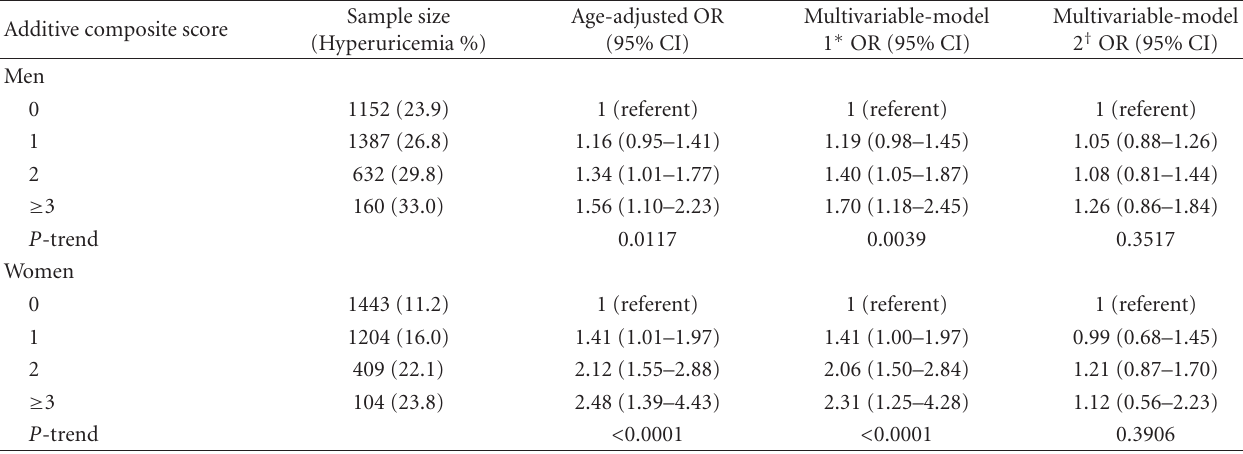
Table 3: Association between sleep variables and hyperuricemia, by gender.